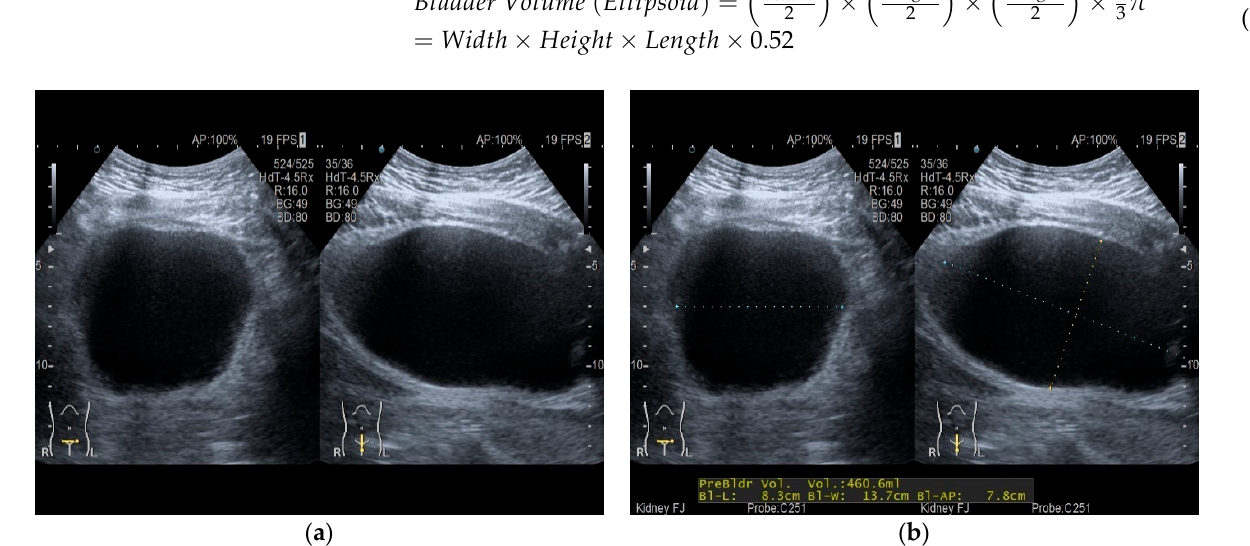
Figure 1. Traditional bladder volume estimation. ( a ) B-mode ultrasound of bladder, with transverse view ( left ) and sagittal view ( right ) shown. ( b ) Width is measured from a transverse view ( left ); height and length are measured from a sagittal view ( right ).